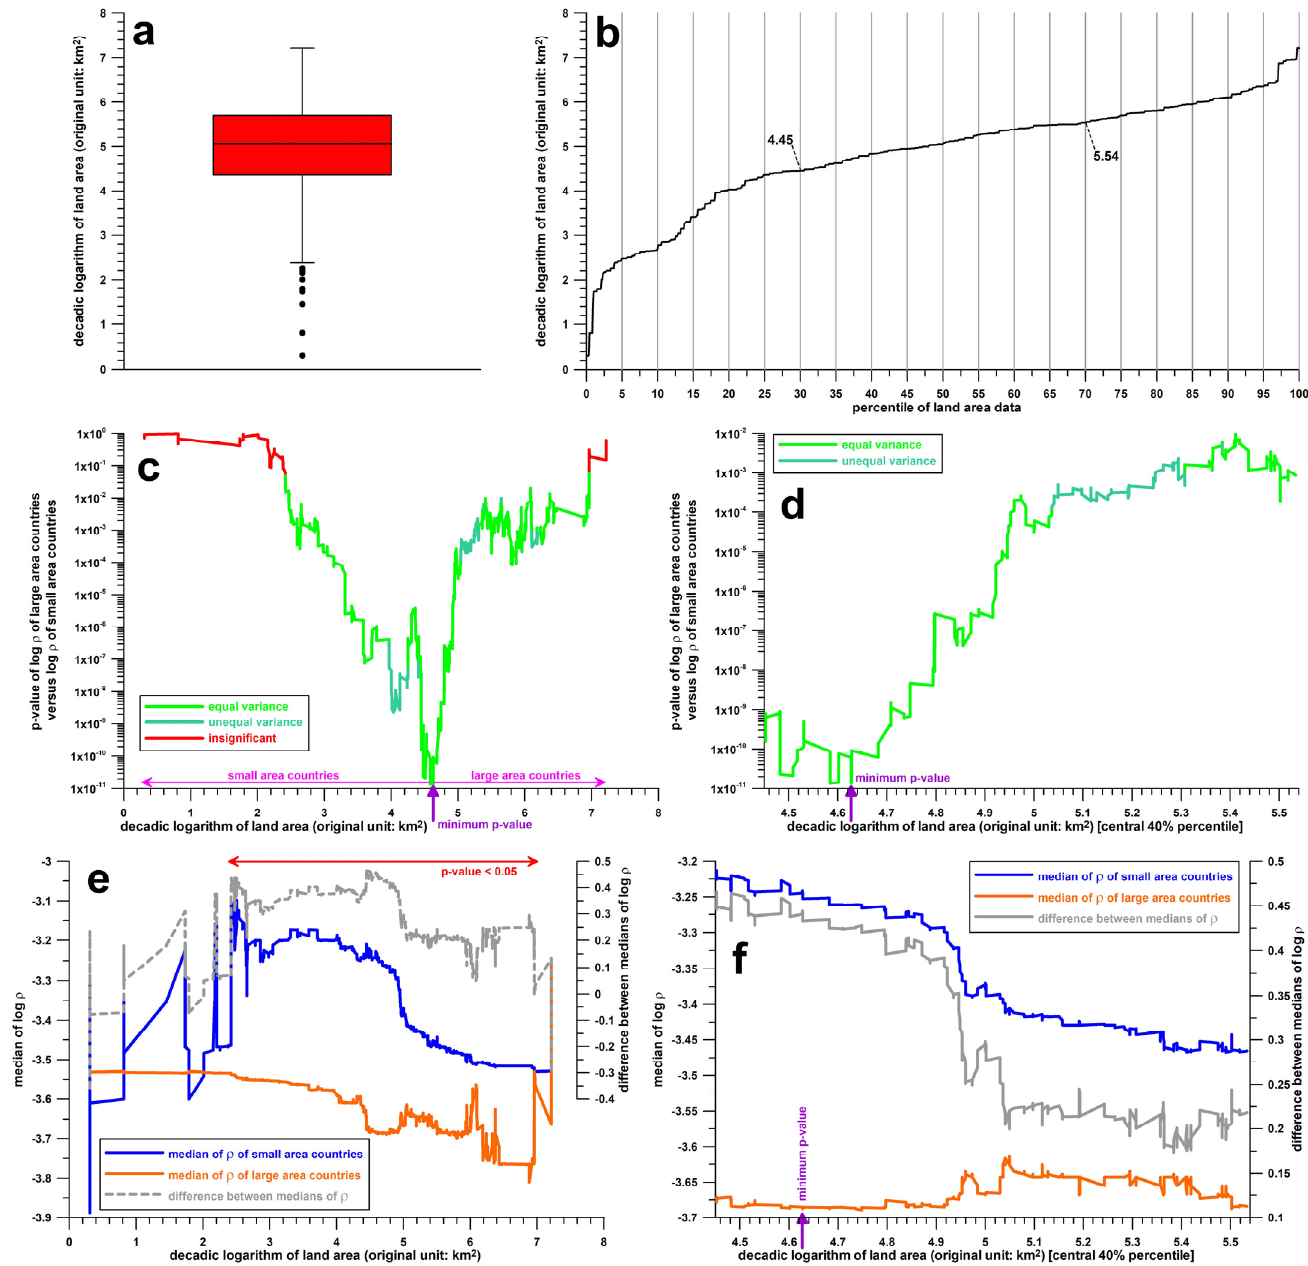
Figure 3. Running Line Method; ( a ) Box and Whisker plot of the logarithm of the land area (log A of countries shown in Appendix A); ( b ) log A against the percentile of land area; boundary values of log A, associated with the 30th and 70th percentile (central 40% percentile); ( c ) p -values associated with each line of separation, dividing the land area into large and small countries, against the %ile of land area; ( d ) enlarged section of c (central 40% percentile); ( e ) the medians of log ρ of small and large area countries at any separation line, including the difference of the medians, against the %ile of land area; ( f ) enlarged section of ( e ) (central 40% percentile).